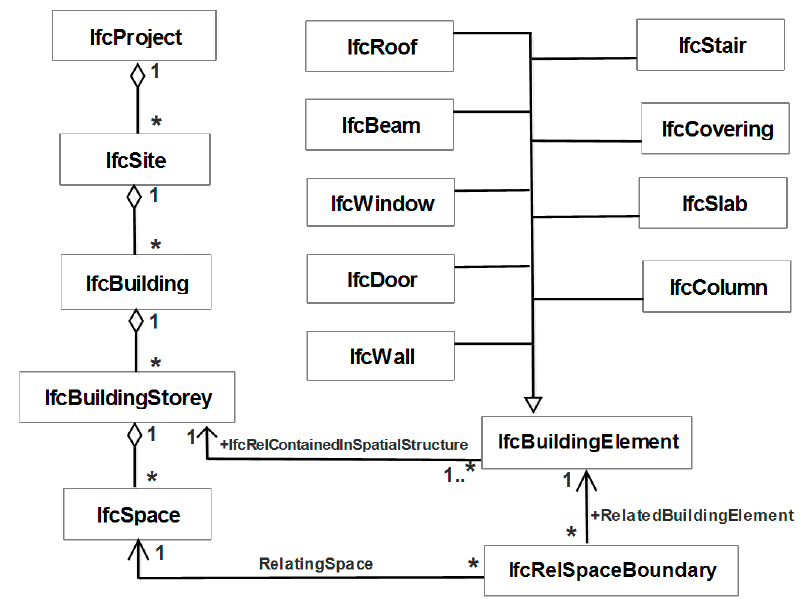
Figure 1. Hierarchical storage of building information in IFC standard.